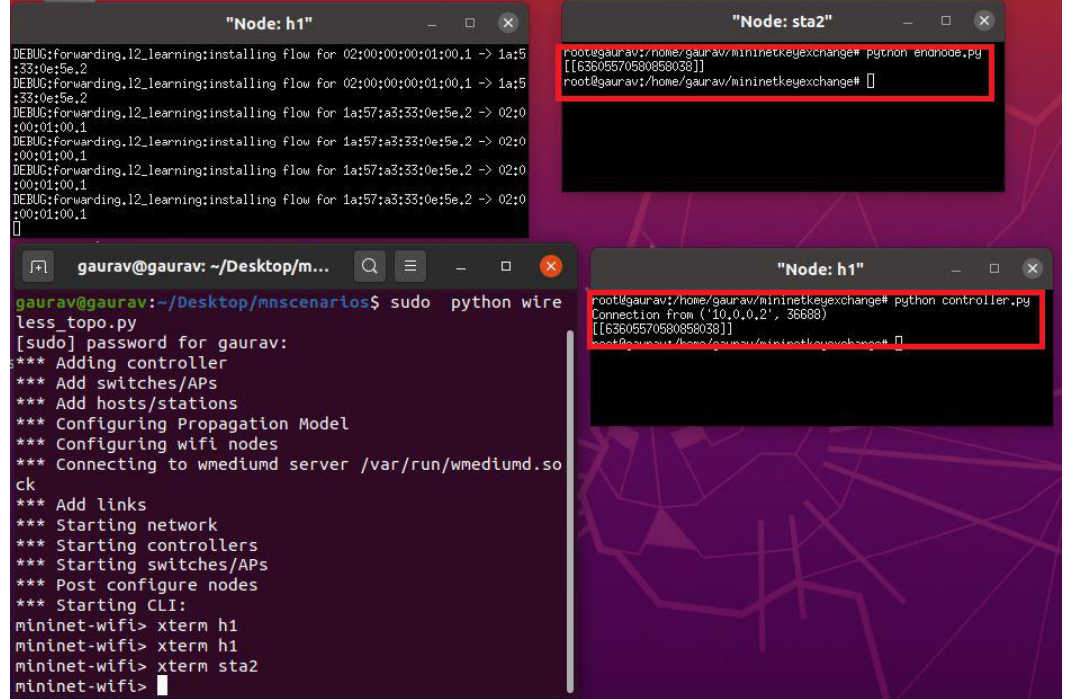
Figure 5. Key Exchange Verification in Mininet-WiFi.